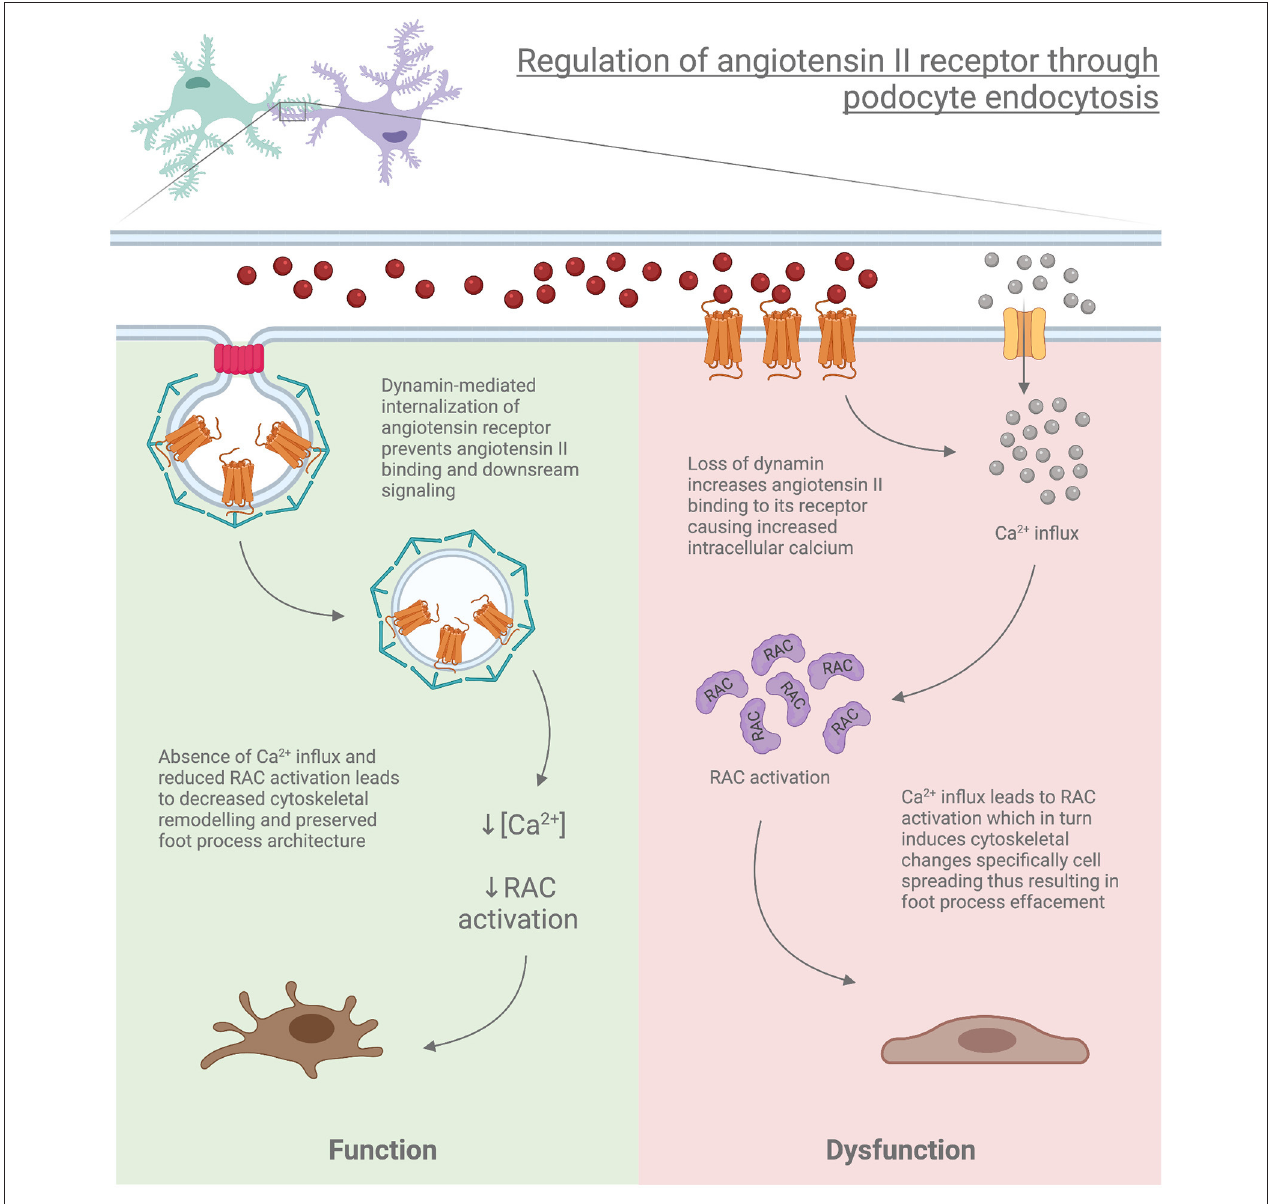
FIGURE 3 | Regulation of angiotensin II receptor through podocyte